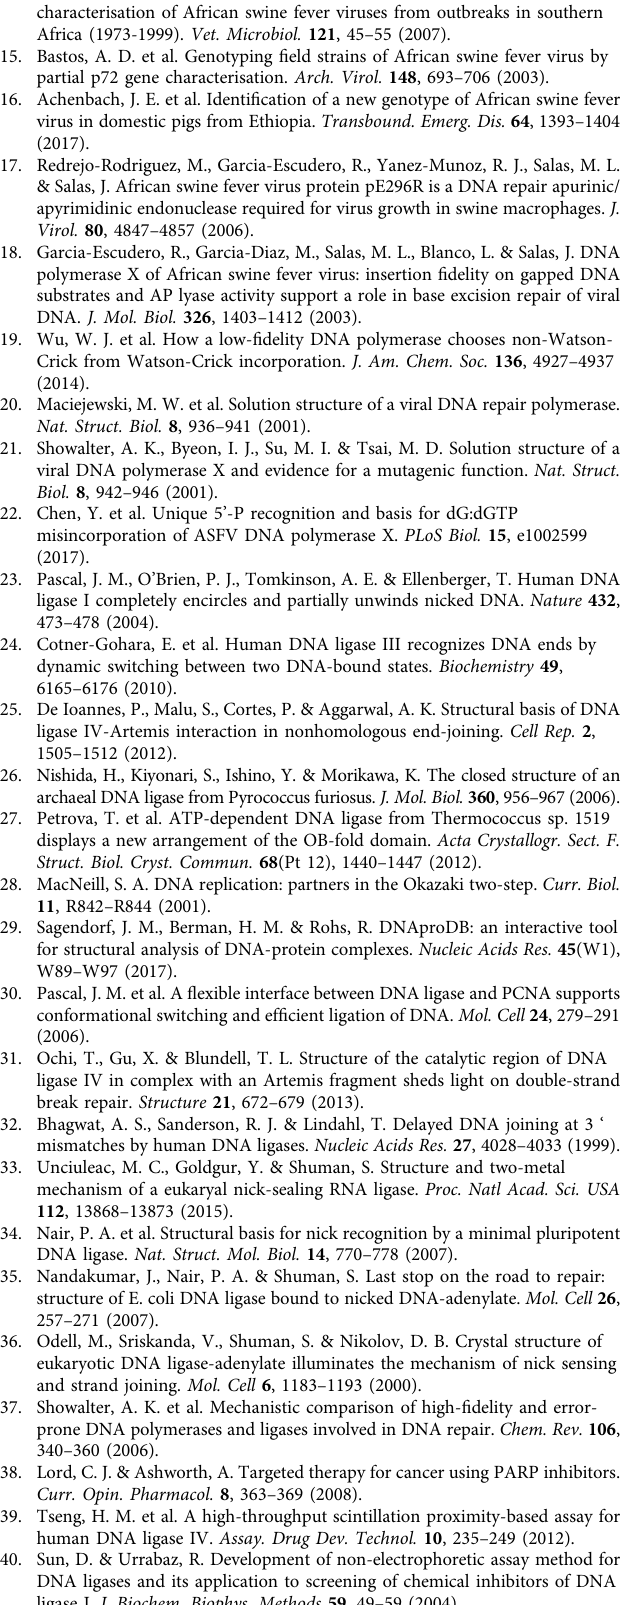
Table 7. The crystallization samples were prepared by mixing Asfv LIG, DNA, and MgCl 2 and/or ATP (if present) at room temperature. The initial crystallization conditions for all crystals were identi fi ed at 18 °C using the crystallization robot system and commercial crystallization kits. During the initial screening, the sitting- drop vapor diffusion method was used, whereas all the crystal optimization pro- cedures were performed using the hanging-drop vapor diffusion method. The compositions of the fi nal crystallization conditions are also listed in Supplementary Table